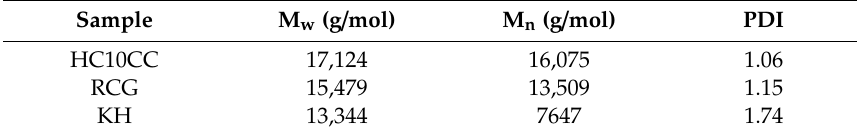
Table 3. M w , M n , and polydispersity index (PDI) of HC10CC, RCG, and KH extracts used for preparation of electrospun protein-based